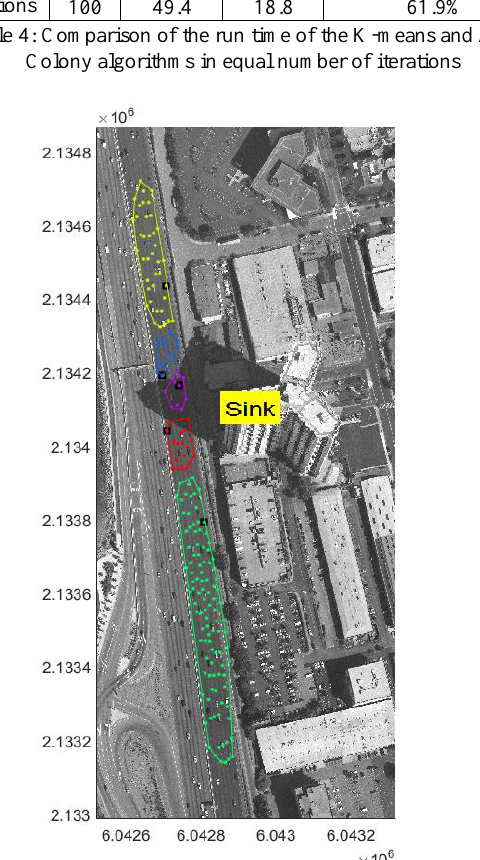
Figure 3: Clustering obtained by the implementation of the ANT Colony algorithms in 100 iterations